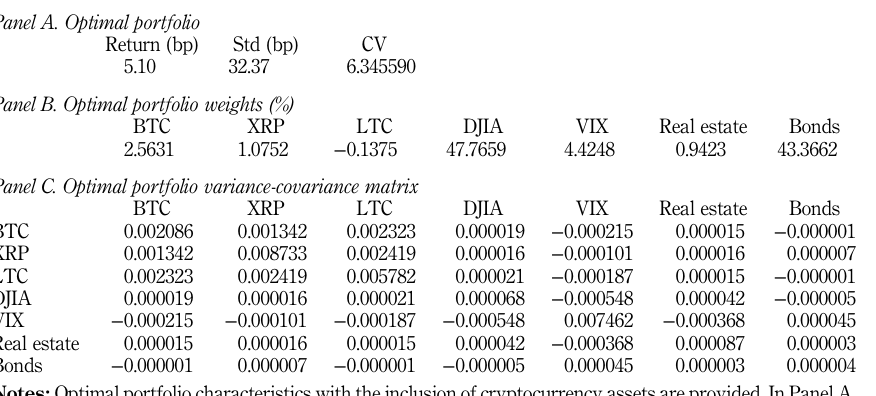
Table III. Optimal portfolio